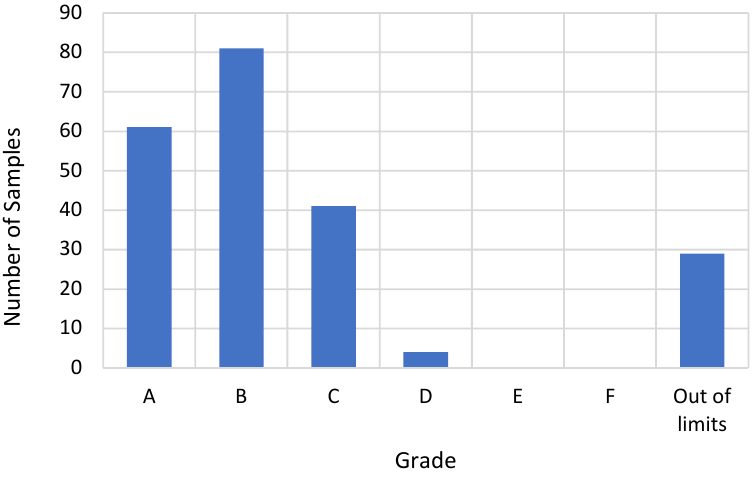
Figure 2. Number of samples for different aggregate Figure 2. number of samples for different aggregate gradations